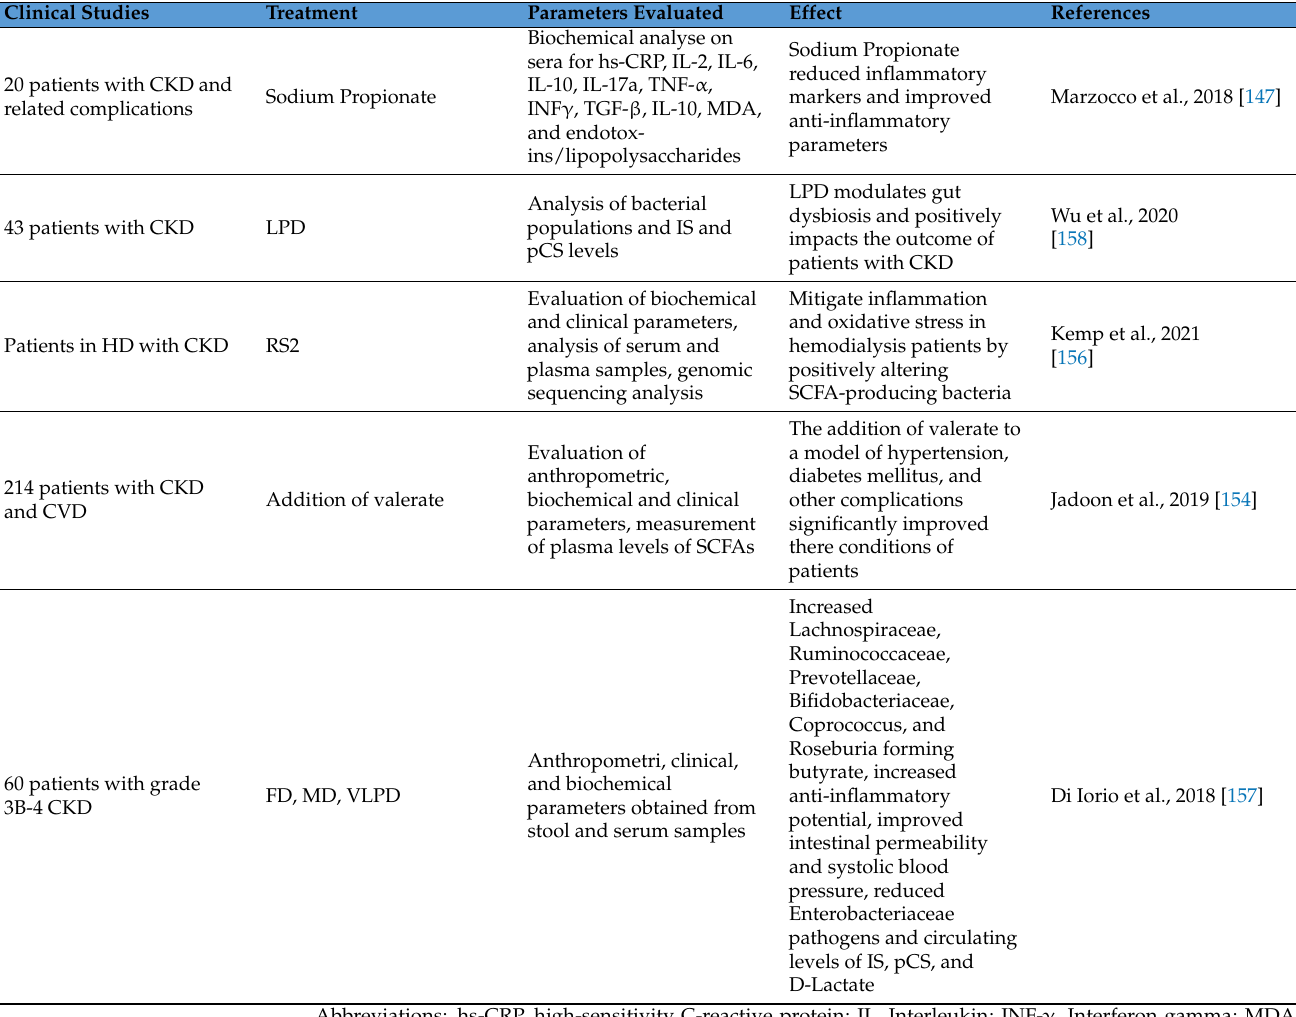
Table 3. Clinical studies report a related improvement in SCFA levels both in in vitro and animal